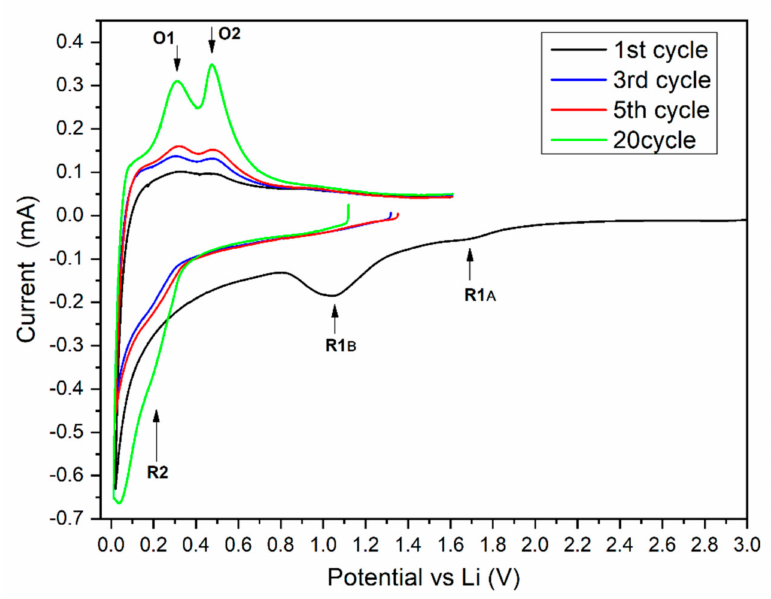
Figure 5. Cycle voltammetry of Si-2 electrode in cycles 1, 3, 5 and